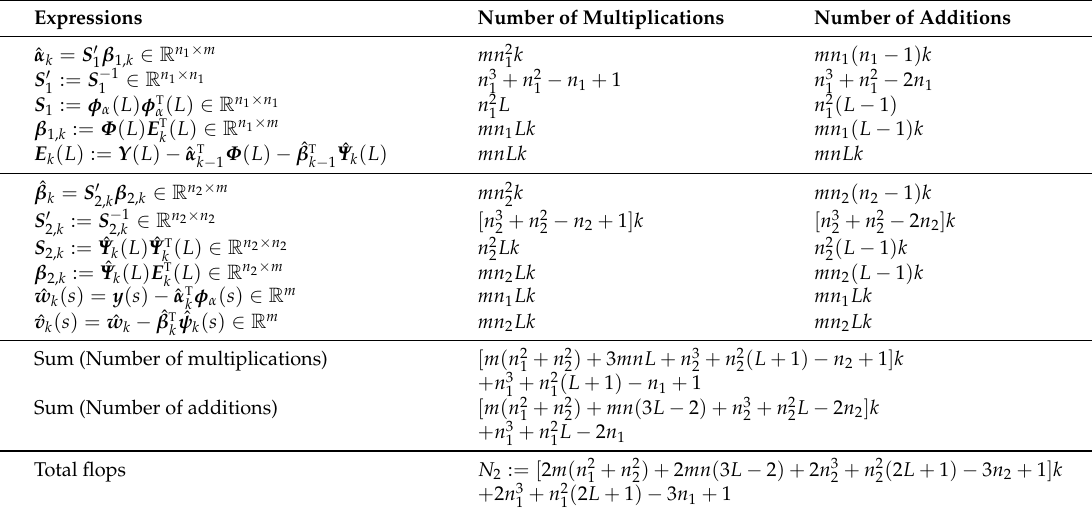
Table 2. The computational efficiency of the hierarchical least-squares-based iterative identification